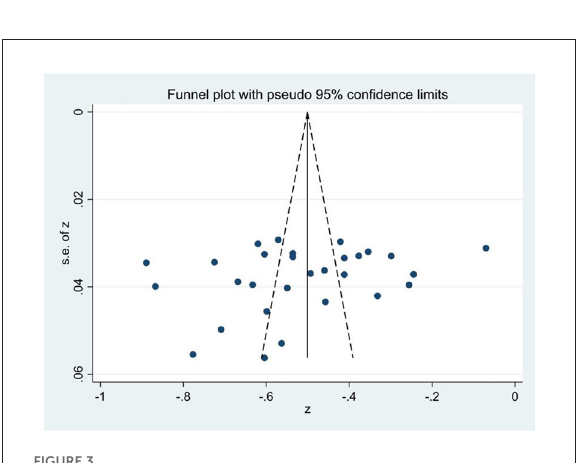
FIGURE3 Funnel plot of the correlation of smartphone addiction and self-control.